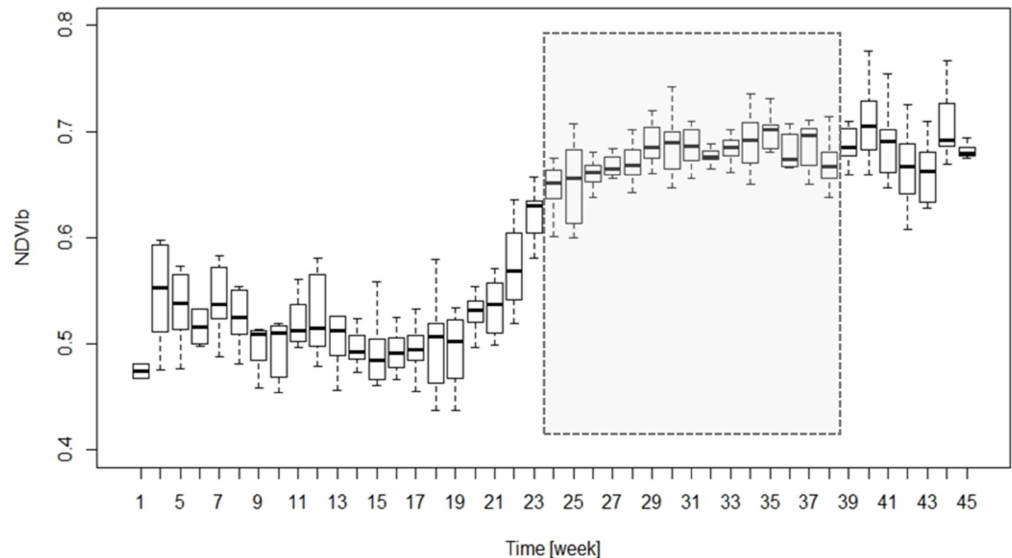
Figure 3. The seasonal run of weekly populations of broad–band normalized difference vegetation index (NDVIb) collected at Rzecin peatland in 2016. The grey rectangle indicates the extracted period (weeks 24–38). Error bars indicate minimum and maximum values, the top of the boxes shows 25th percentile and the bottom 75th percentile, and horizontal line is median value.